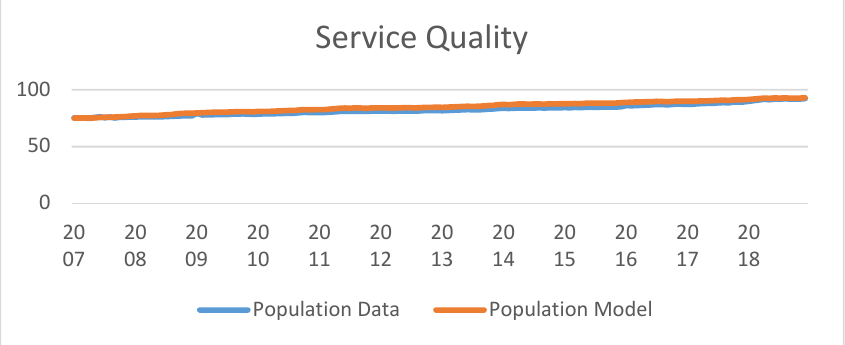
Fig. 4 Comparison of data population and data